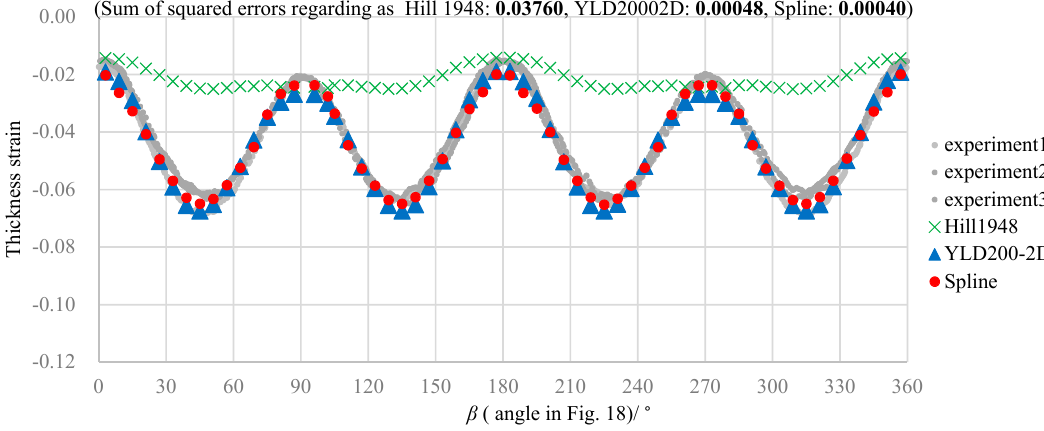
Figure 24. Comparison of thickness strain distributions on circle 3 in experimental condition B.